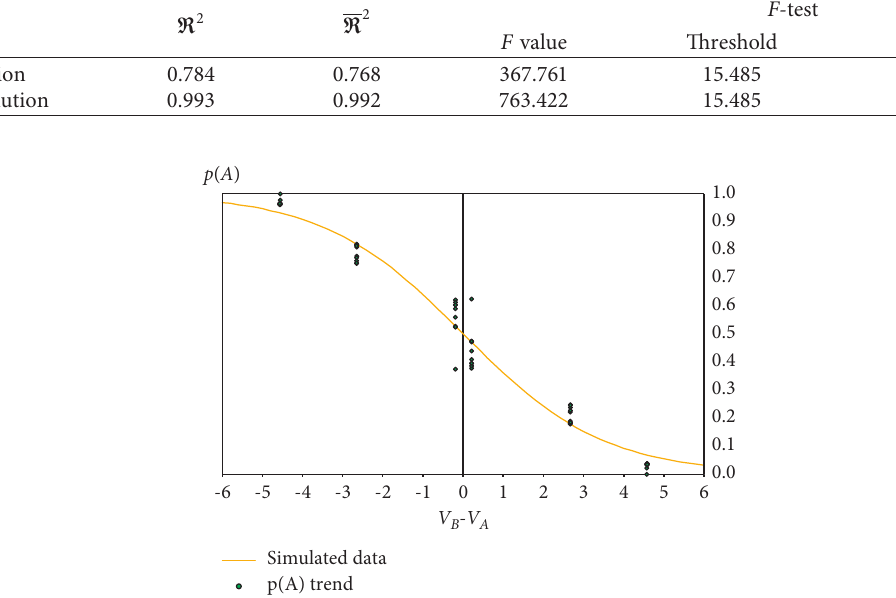
− V B A ) for the integrated solution.